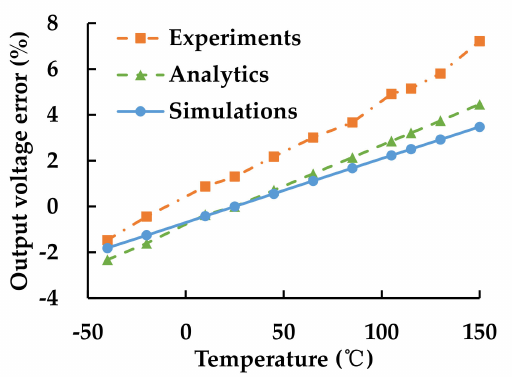
Figure 9. Comparison of the output error of the MEMS pressure sensor, at different temperatures, under 0 kPa pressure.